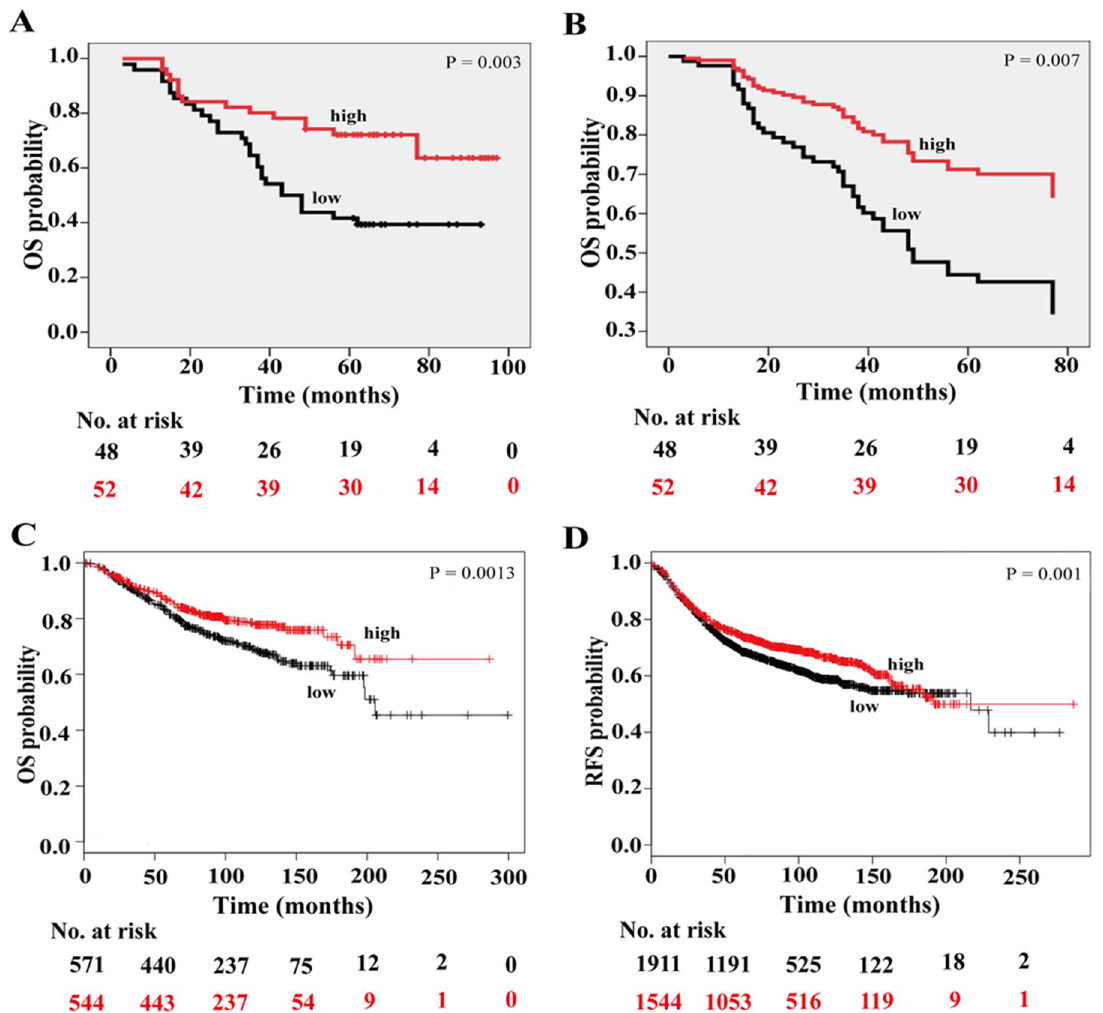
Figure 3. Low C10orf10 expression is correlated with shorter survival in BC patients. (A) Survival analysis of C10orf10 protein expression in 100 BC patients by Kaplan-Meier survival curve. Tissue array analysis was performed in 100 cases of patients with the survival information. The patients with low expression had a poorer overall survival than those with high expression; HR, hazard ratio; low, staining negative and weak; high, staining moderate and strong. (B) Survival analysis of C10orf10 expression in 100 BC patients by multivariate Cox regression. The C10orf10 expression is an independent prognostic factor. (C) Kaplan-Meir survival analysis of C10orf10 mRNA in 1115 BC patients with Kaplan-Meier Plotter (http://kmplot. com/analysis/index). The overall survival was longer in the C10orf10 high expression group than in the C10orf10 low expression group. Auto select best cutoff was chosen in the analysis; Cutoff value used was 1086; Expression range of the probe was 143–3881. (D) Kaplan-Meir survival analysis of C10orf10 mRNA in 3455 BC patients with Kaplan-Meier Plotter. The relapse-free survival was longer in the C10orf10 high expression group than in the C10orf10 low expression group. Auto select best cutoff was chosen in the analysis; Cutoff value used was 1088; Expression range of the probe was 32–5515. analyzed survival data of each grades by stratifying the patients based on the C10orf10 expression levels. The results indicated that C10orf10 expression was not statistically associated with the OS times of BC patients at grade 1 (HR= 0.79, P= 0.61) and grade 3 Now there is still a compelling question that whether low (HR =0.76, P =0.18). While, there was a statistically effect of low expression of C10orf10 also predict poorer survival of the BC C10orf10 expression on the poorer OS of the BC patients at grade patients with different lymph node statuses and ER statuses. We 2 (HR =0.45, P= 0.00059) (Figure 4D). These findings suggest observed a statistically effect of low C10orf10 expression on the that low expression of C10orf10 is an unfavorable factor for the poorer survival of the BC patients who were lymph node negative prognosis of the BC at grade 2. (HR =0.66, P = 0.048) and ER positive (HR= 0.61, P= 0.021) (Figure 5A, 5B), but no effect on that of the patients who were lymph node positive (HR= 0.63, P =0.089) and ER negative (HR =0.62, P =0.095).